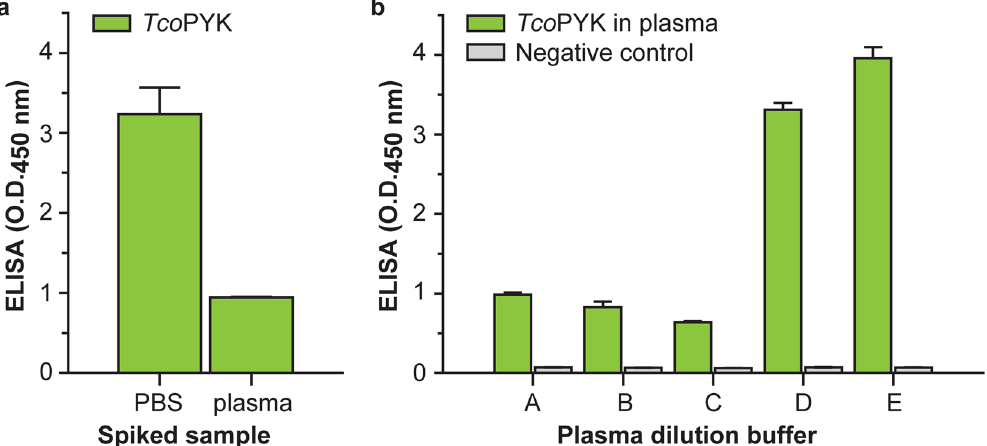
Figure 3. Optimisation of the Nb44/Nb42 ELISA assay buffer counteracts the plasma matrix effect. ( a ) Nb44/ Nb42 ELISA tested on PBS and naive mouse plasma spiked with Tco PYK at a concentration of 1 μ g ml − 1 . ( b ) Nb44/Nb42 ELISA tested on naive mouse plasma spiked with Tco PYK at a concentration of 1 μ g ml − 1 and diluted three-fold in various assay buffers (A: PBS, B: PBS + 100 mM NaCl, C: PBS + 300 mM NaCl, D: PBS + 0.5% Tween20, E: PBS + 1.0%